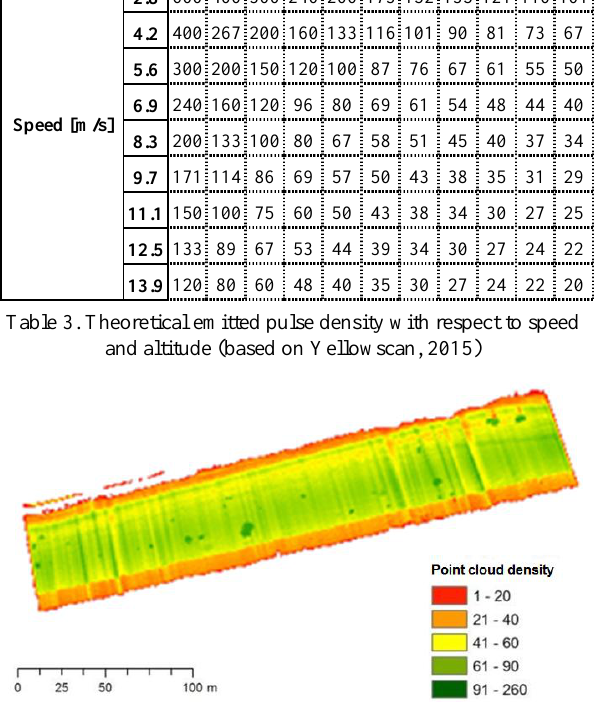
Figure 3. The point cloud density for a single scanned path from an ultra-light scanner (flight altitude 30 AGL) The other photogrammetric sensor mounted on the platform is a APS-C (23.2 × 15.4 mm) with a resolution of 24.3 Mpix (dimensions of